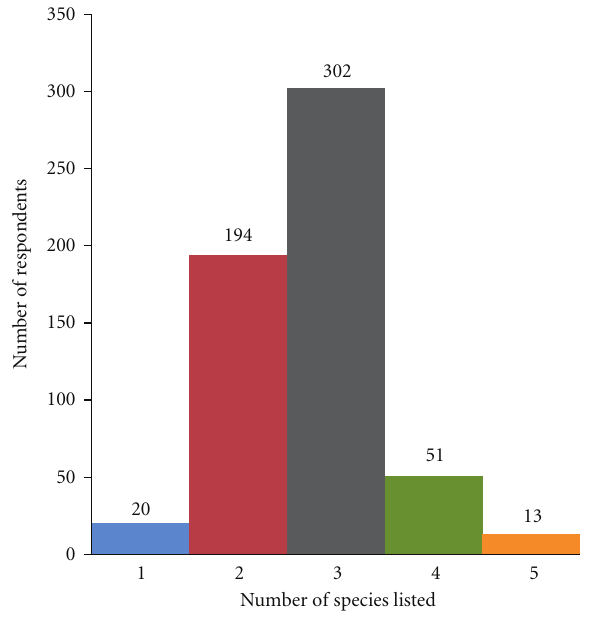
Figure 2: Variation of the number of respondents with the number of species